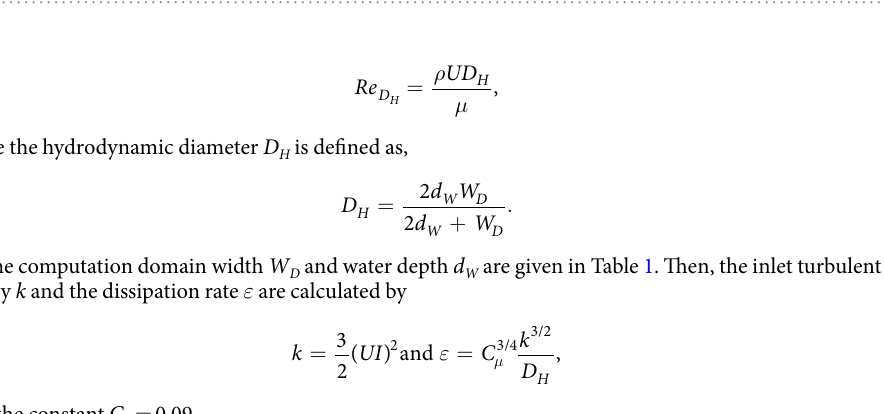
Figure 10. Computational mesh showing a detailed surface mesh for the killer